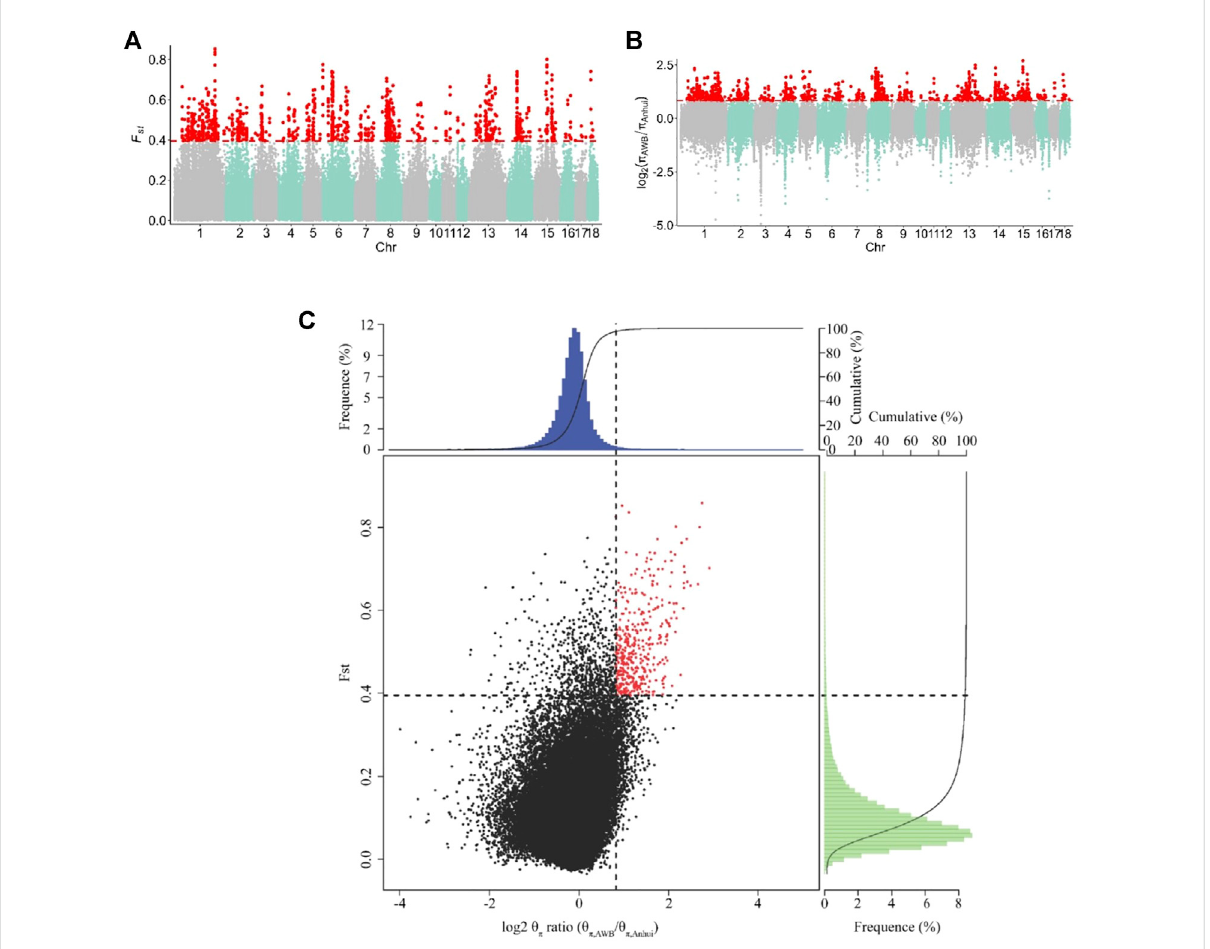
FIGURE 4 Identi fi cationofgenomicregionswithstrongselectivesweepsignalsinAnhuisixpigpopulation,whicharecalculatedina40-kbslidingwindow approach with 20 kb step-size. (A) Distribution ofFST values among autosome chromosomes. The red line represents the 0.01 level. (B) Distribution oflog 2 ( θπ ratio)amongautosomalchromosomes.Theredlinerepresentsthe0.01level. (C) The fi nalselectionregionsbasedontwostatistics.Points located to the rightof thevertical dashed lines(corresponding to 1% right tails ofthe empirical log 2 ( θπ ratio) distribution,where log 2 ( θπ ratio) is 0.824992) and above the horizontal dashed line (1% above tail of the empirical FST distribution, where FST is 0.395220) were identi fi ed as selected regions for Anhui pig population (red points). The AWB refer to Asia wild boar, the Anhui refer to Anhui pig